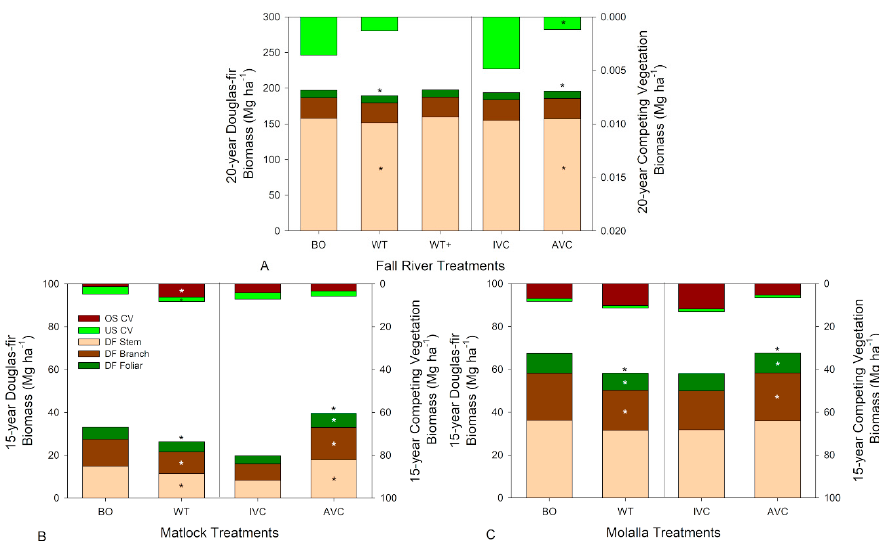
Figure 5. Plot-level Douglas-fir stem, branch, and foliar biomass compared to overstory (OS) and understory (US) competing vegetation (CV) by treatment at each site. Asterisks within bars understory(US)competingvegetation(CV)bytreatmentateachsite. Asteriskswithinbars(components) (components) or on top of bars (total) designate significant differences ( p < 0.10) in biomass from the or on top of bars (total) designate significant di ff erences ( p < 0.10) in biomass from the BO or IVC BO or IVC treatments. Y -axis scales are different for Fall River ( A ) due to larger Douglas-fir biomass treatments. Y -axis scales are di ff erent for Fall River ( A ) due to larger Douglas-fir biomass and smaller and smaller competing vegetation biomass than at Matlock ( B ) and Molalla ( C ). competing vegetation biomass than at Matlock ( B ) and Molalla ( C